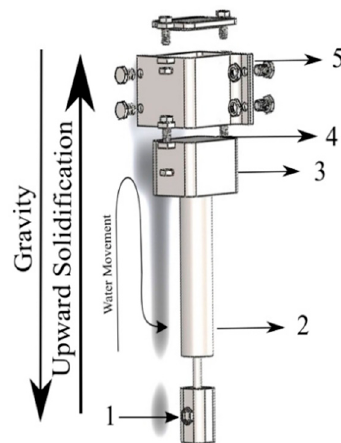
Figure 1. Schematic drawing of the unidirectional solidification device. 1—Water inlet, 2—water outlet, 3—cooling chamber, 4—plate mold, 5—ingot.